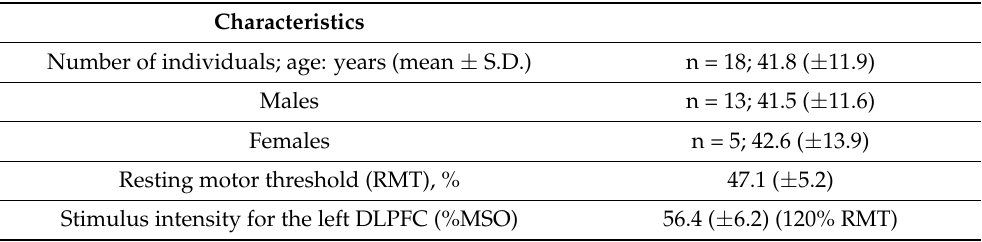
Table 1. Clinico-demographic information.